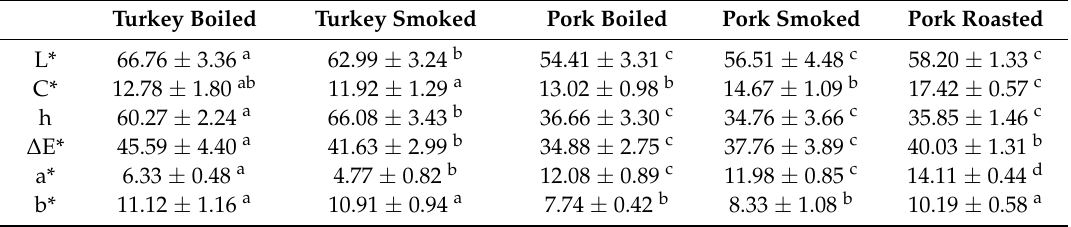
Table 1. Color parameters of turkey and pork hams.